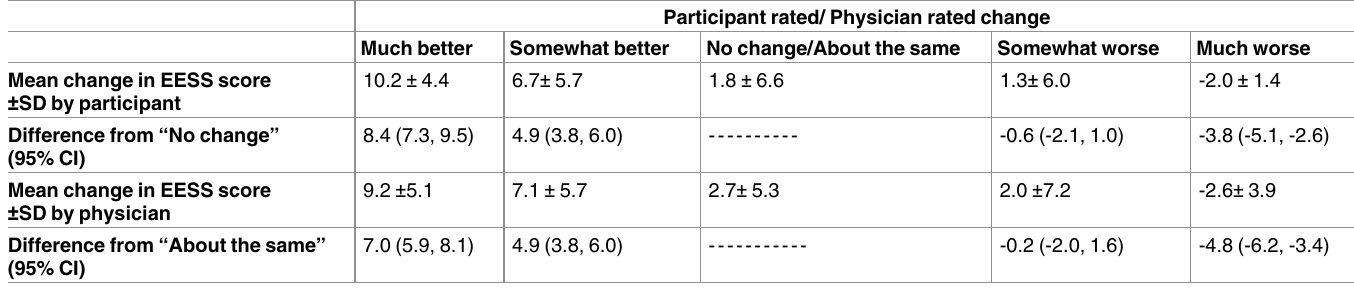
Table 2. Change in EESS score and participant and physician rated change with difference from “No change” or “About the